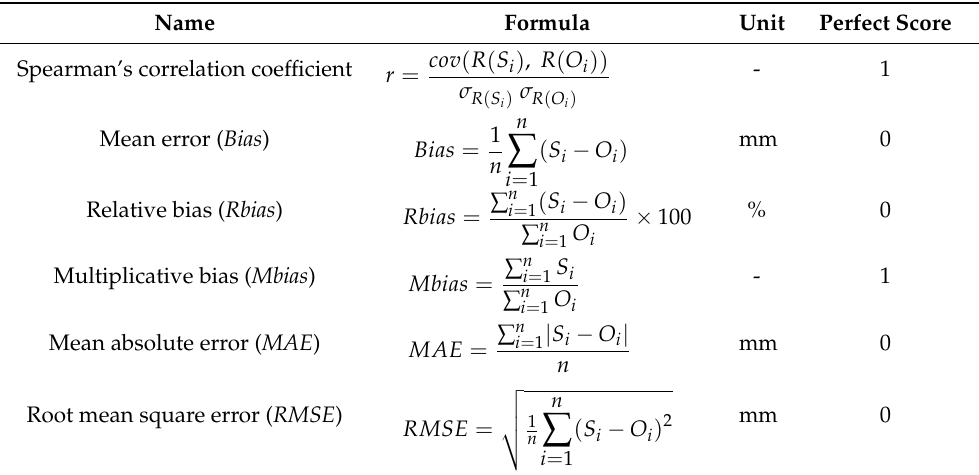
Table 3. List of the continuous verification metrics used to evaluate IMERG